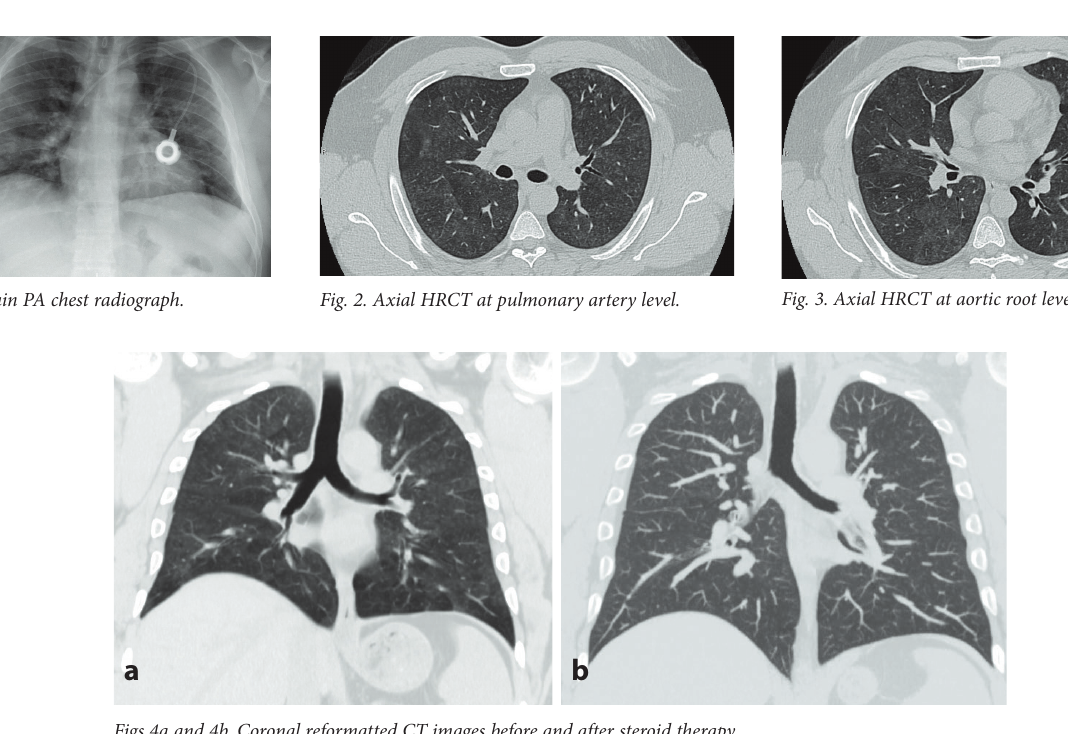
Figs 4a and 4b. Coronal reformatted CT images before and after steroid